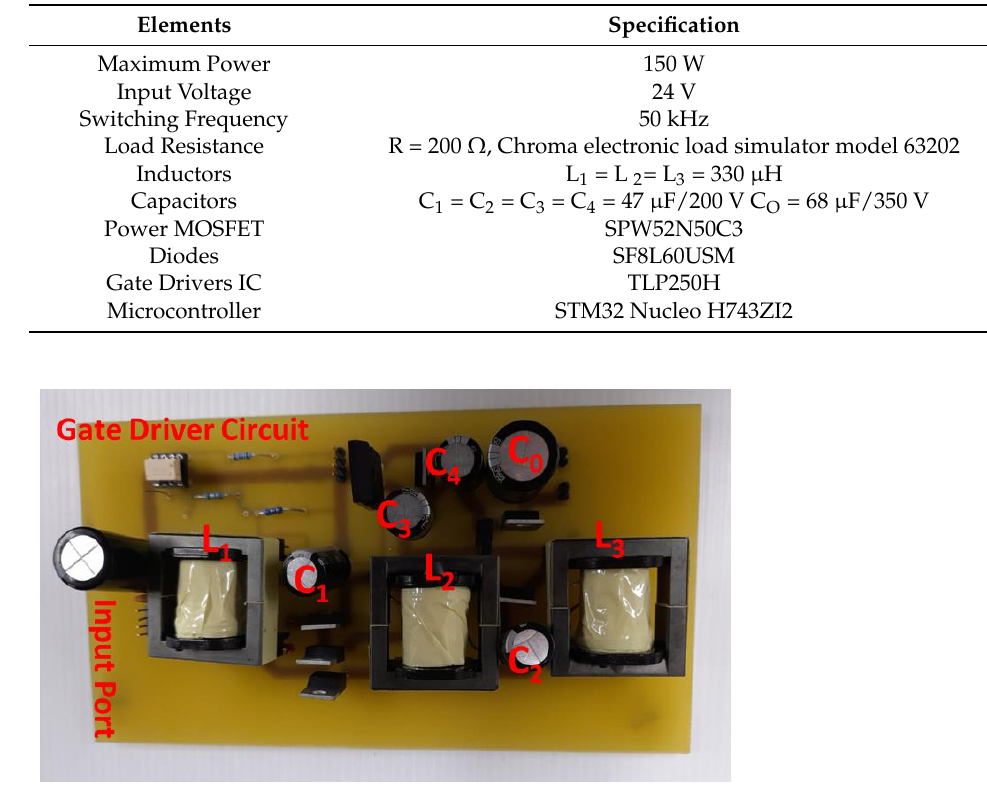
Figure 19. Proposed converter III hardware prototype.